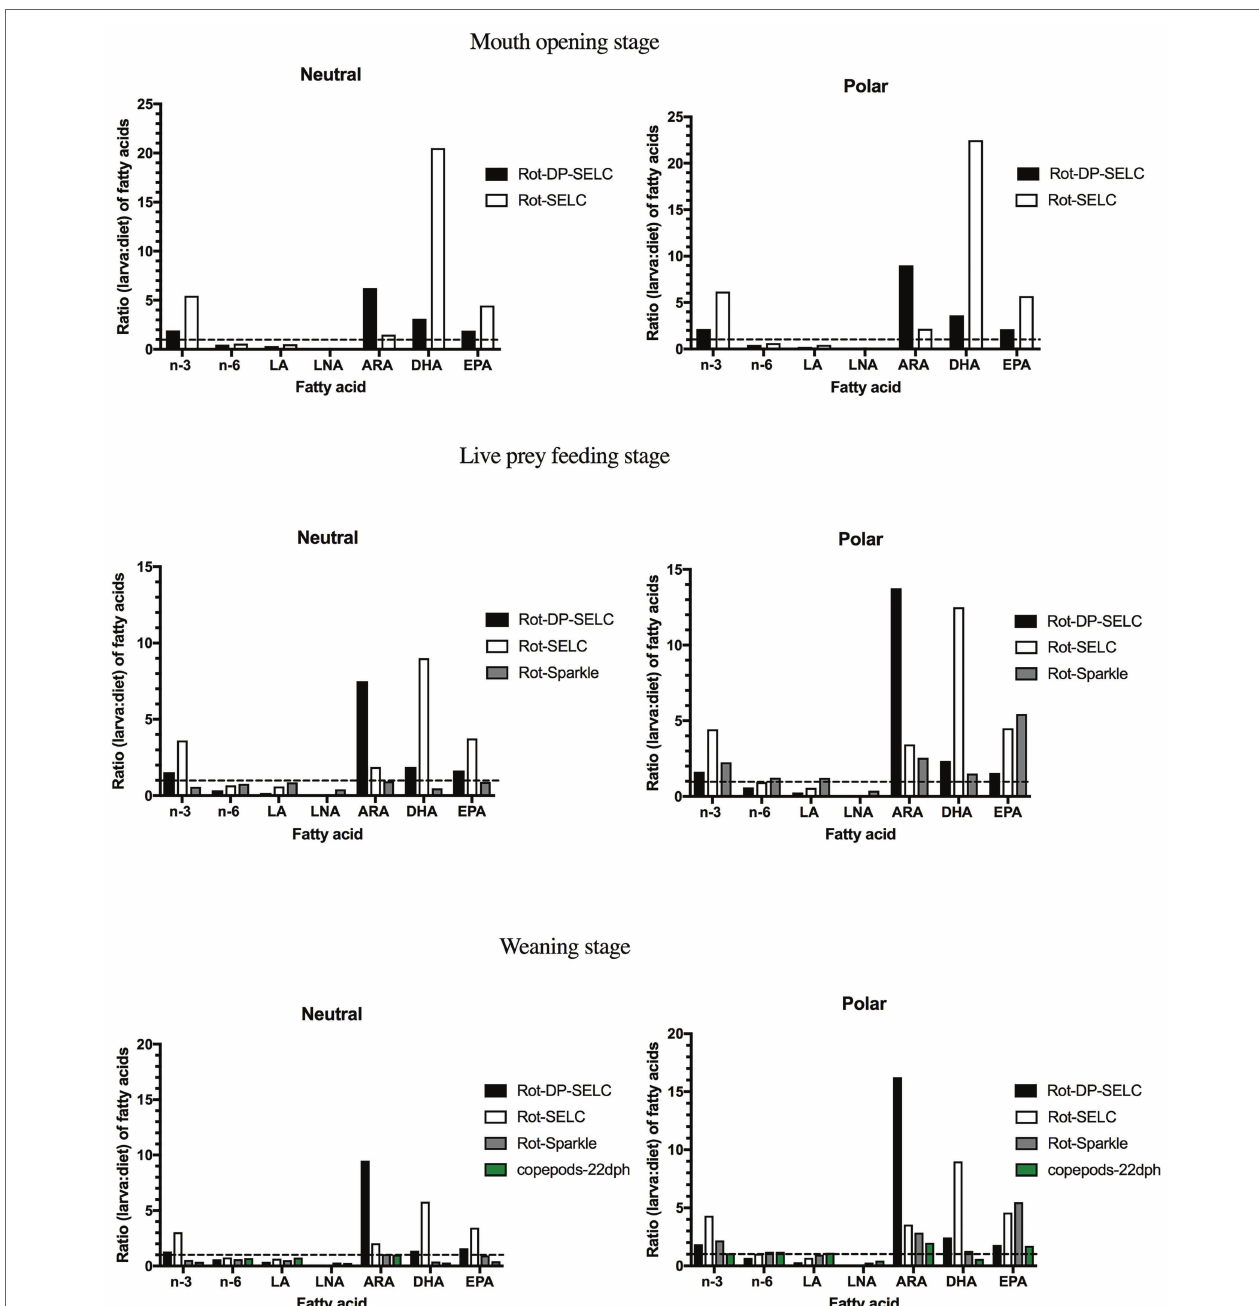
FIGURE 2 | Ratio (larva: diet) of neutral and polar fatty acids in winter flounder ( Pseudopleuronectes americanus ) larvae at mouth opening (4 DPH), live feeding (15–16 DPH), and beginning of weaning (26 DPH). Larvae had been fed several enriched rotifer diets: Selco 3000 (SELC), DHA Protein Selco (DP-SELC), and sparkle-INVE (Sparkle). Larvae at 22 DPH were fed copepods (Seychelles et al., 2011; Martinez-Silva et al., 2018). The dashed lines (ratio = 1) indicate equal amounts of fatty acids in larvae and in the diet. LA, linoleic acid; LNA, linolenic acid; ARA, arachidonic acid; DHA, docosahexaenoic acid; and EPA, eicosapentaenoic